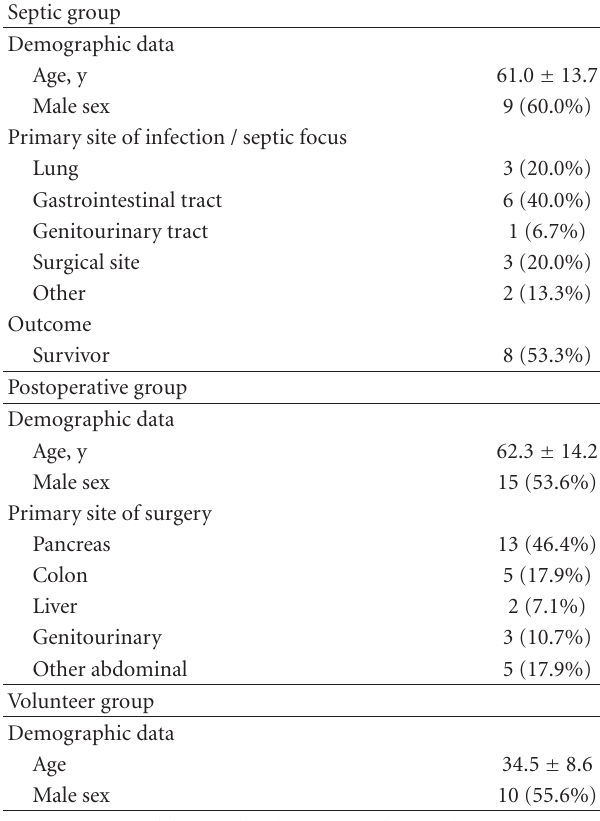
Table 1: Baseline data of 15 patients in the septic group, 28 patients in the postoperative group, and 18 individuals in the volunteer